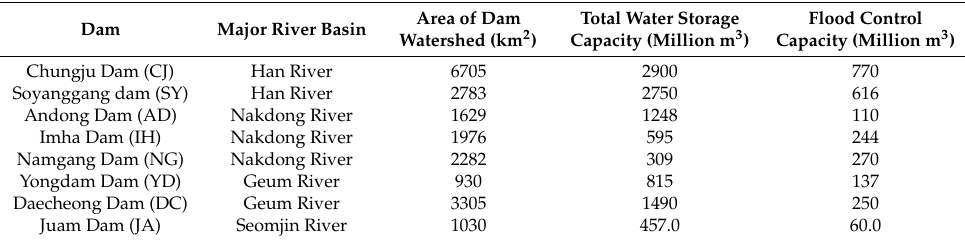
Figure 14. Location of major dam watersheds. Table 1. Major dam